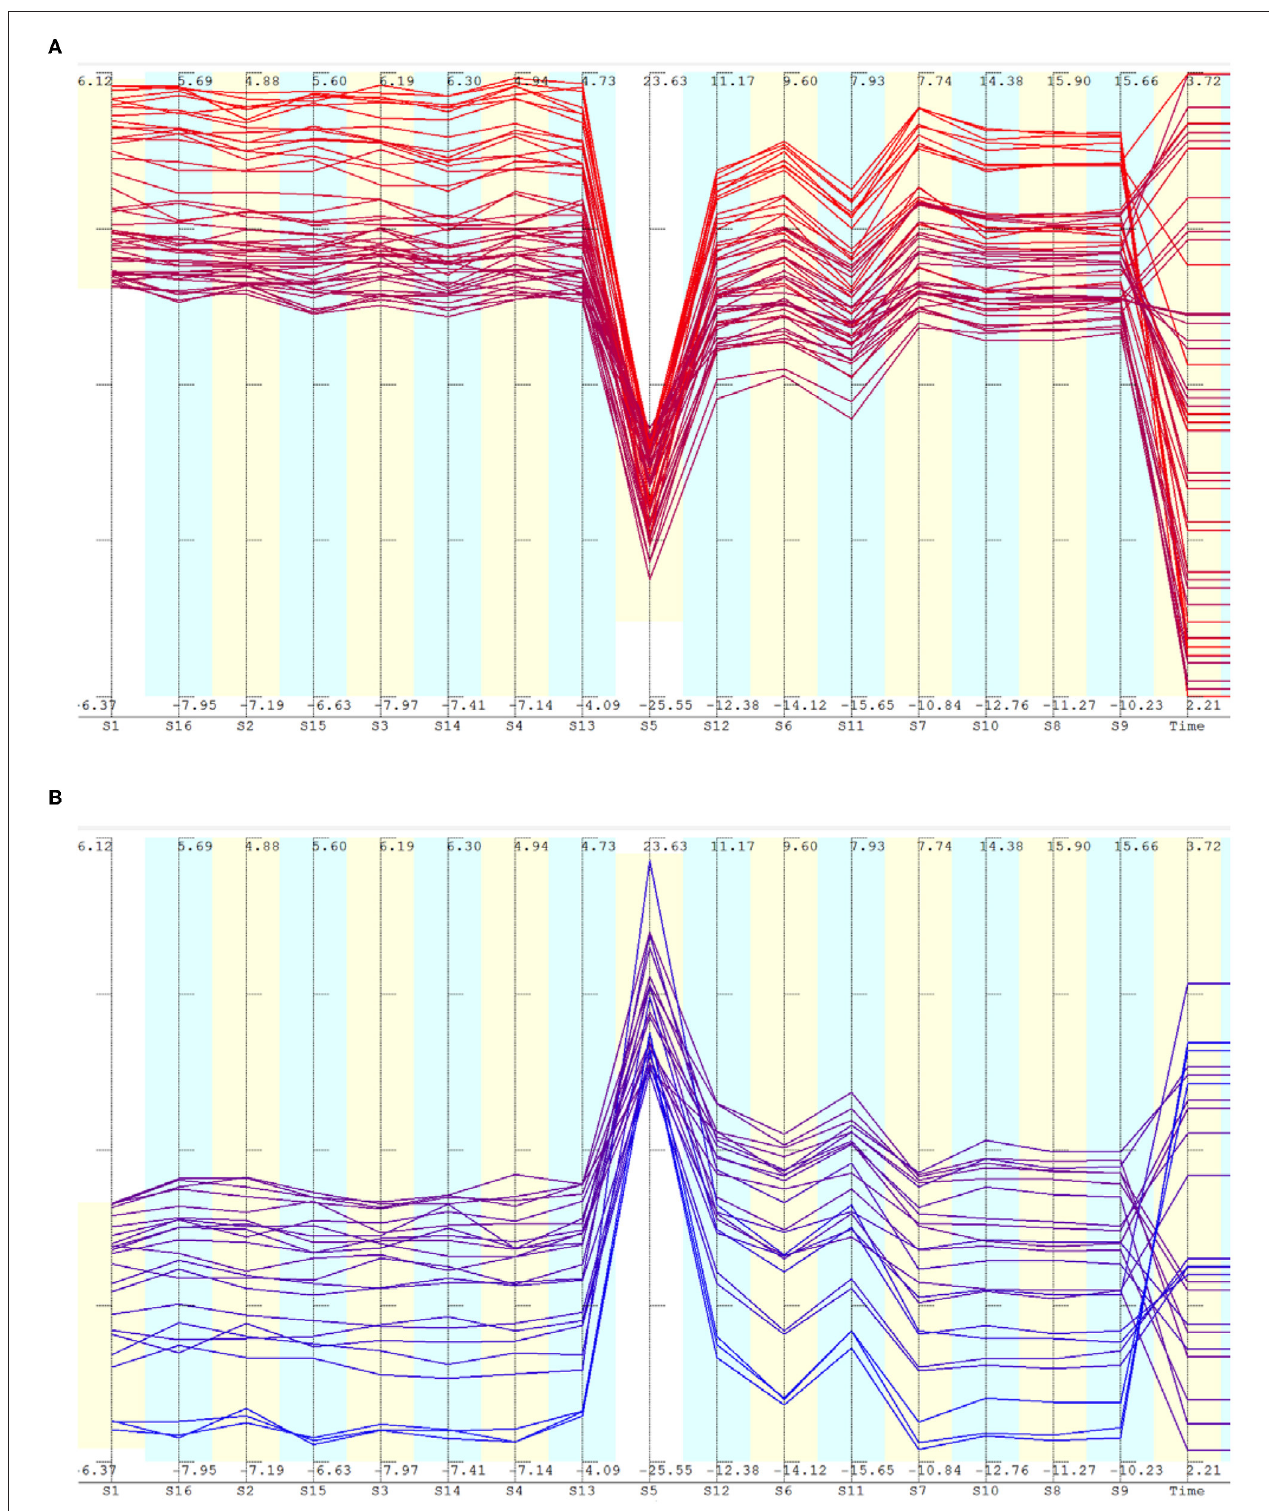
FIGURE 4 | Parallel axis plot of selected strain data during the free vibration phase. (A) Selected data points with low values for sensor S5. (B) Selected data points with high values for sensor S5.